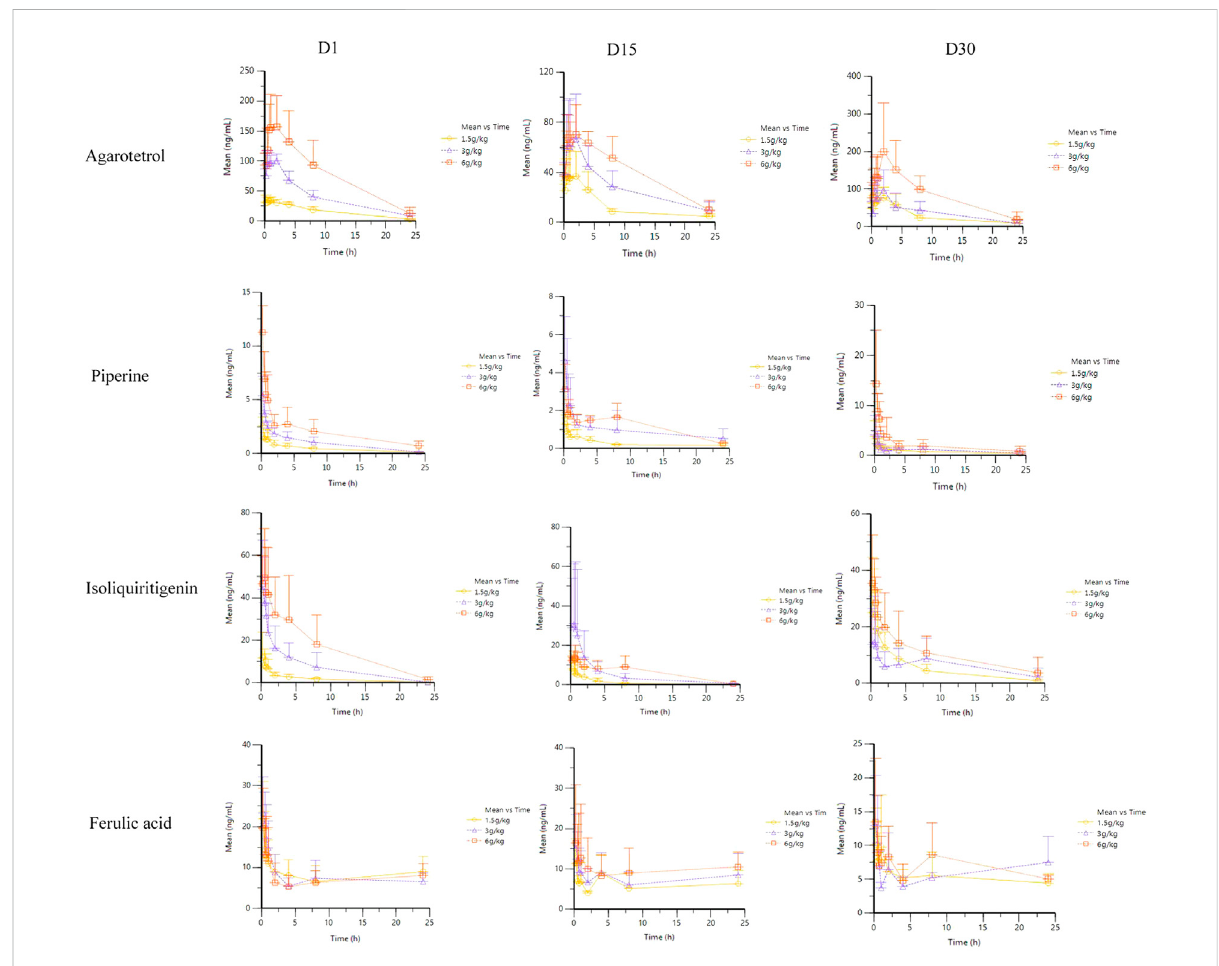
FIGURE 3 Average plasma concentration – time curve of four components at different times after different doses of